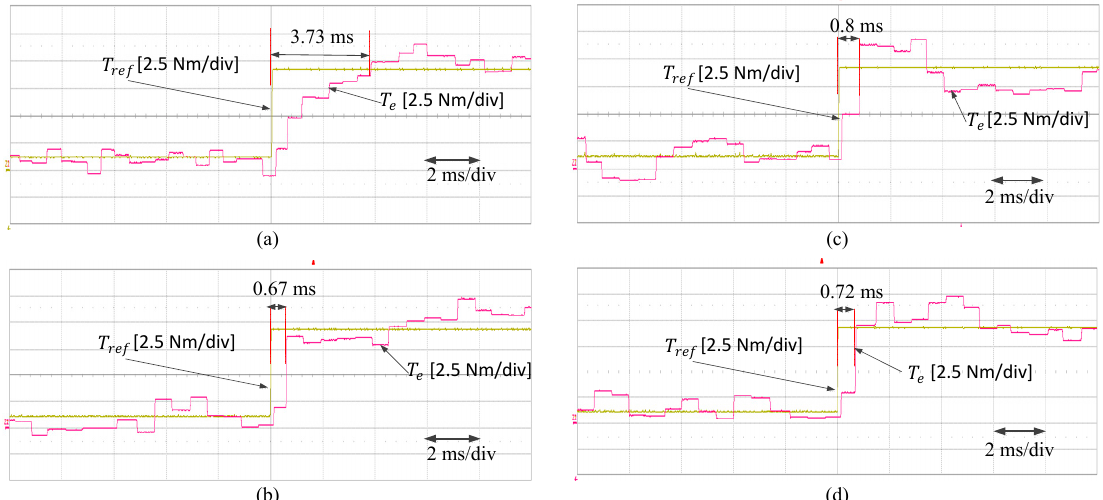
Figure 12. Experimental results of steady-state performance for ( a ) conventional CFTR-DTC, ( b ) interleaving CFTR-3, ( c ) interleaving CFTR-4, and ( d ) interleaving CFTR-5.